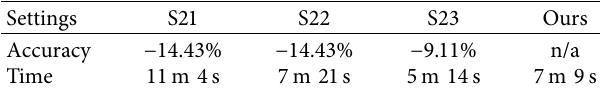
Table 5: Accuracy decrement ( − )/increment (+) and time cost of different algorithms on [6].